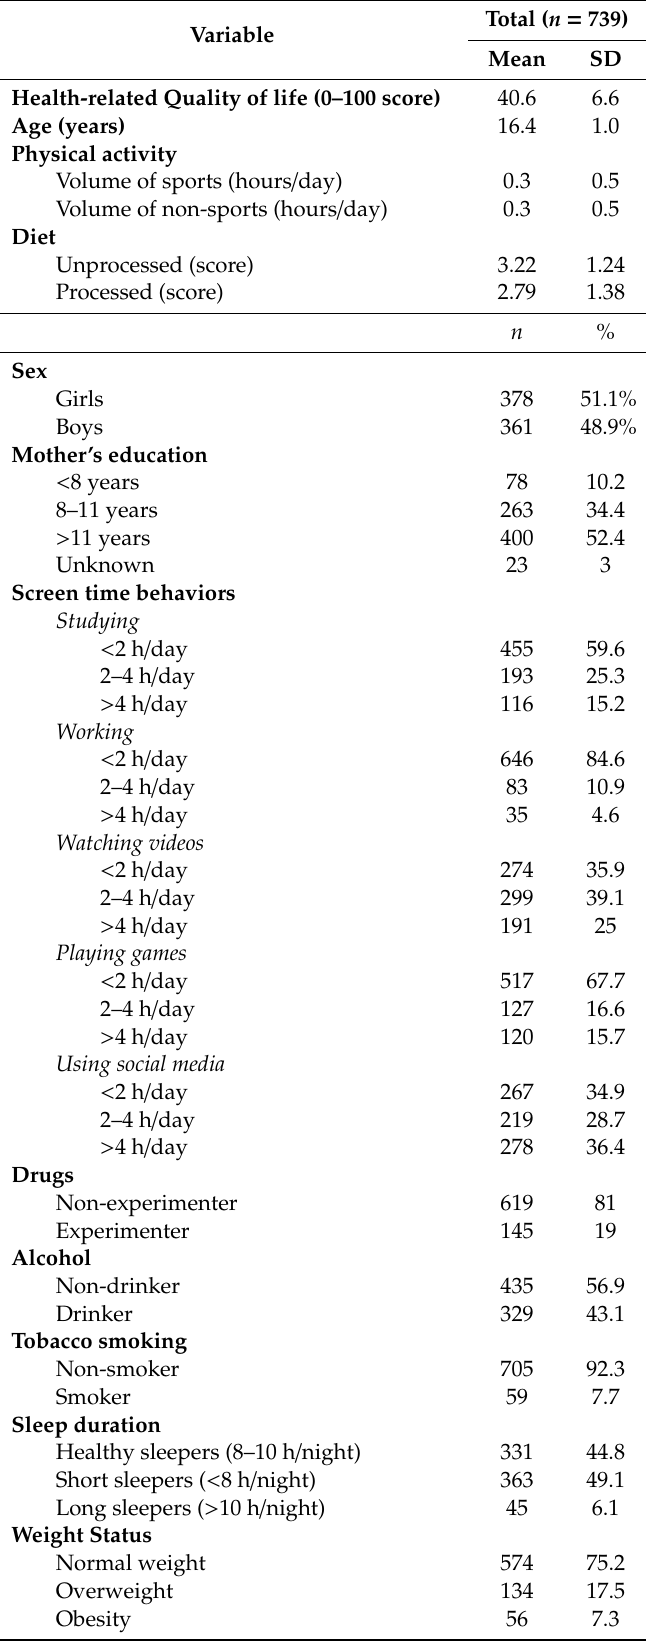
Table 1. Characteristics of the sample of Brazilian adolescents,